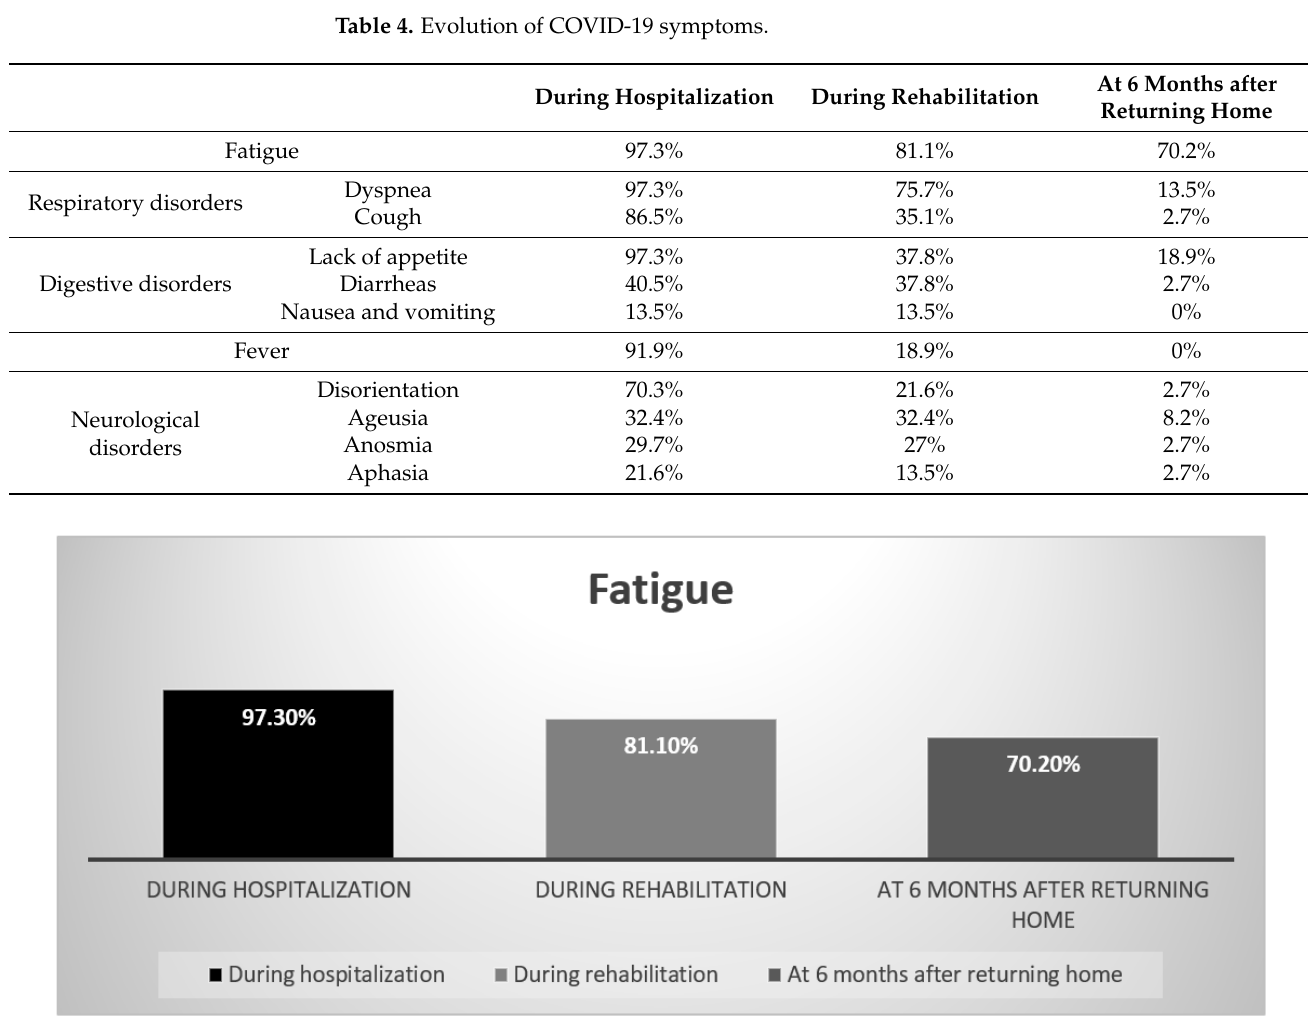
Table 4. Evolution of COVID-19 symptoms.